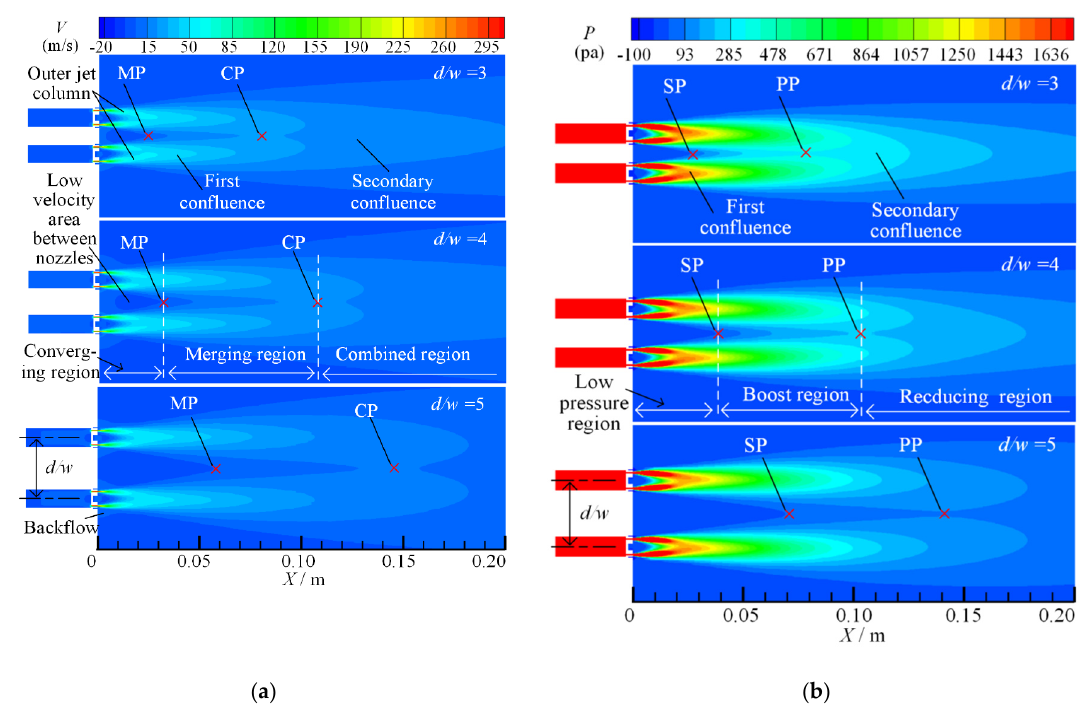
Figure 9. Symmetry plane 2 contours with different nozzle spacing ratios: ( a ) velocity contours; ( b ) pressure contours.